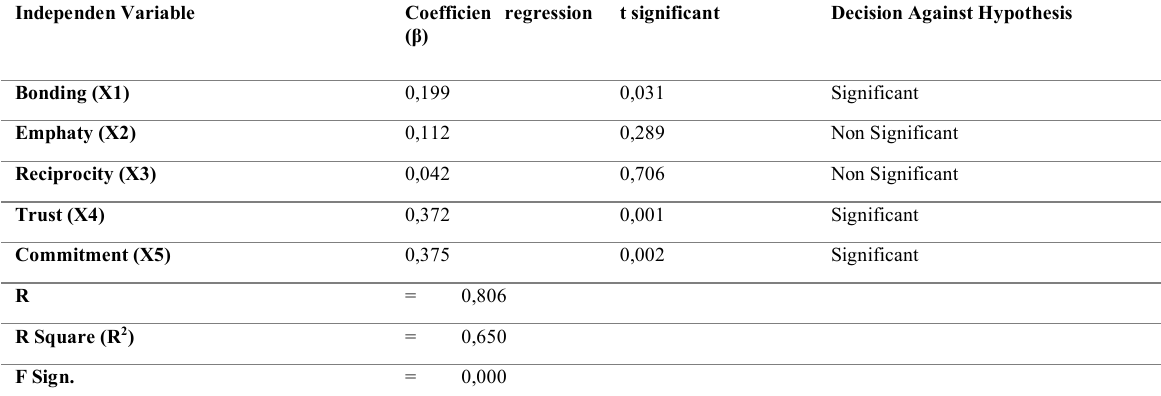
Table 1: Recapitulation of Multiple Linear Regression Analysis